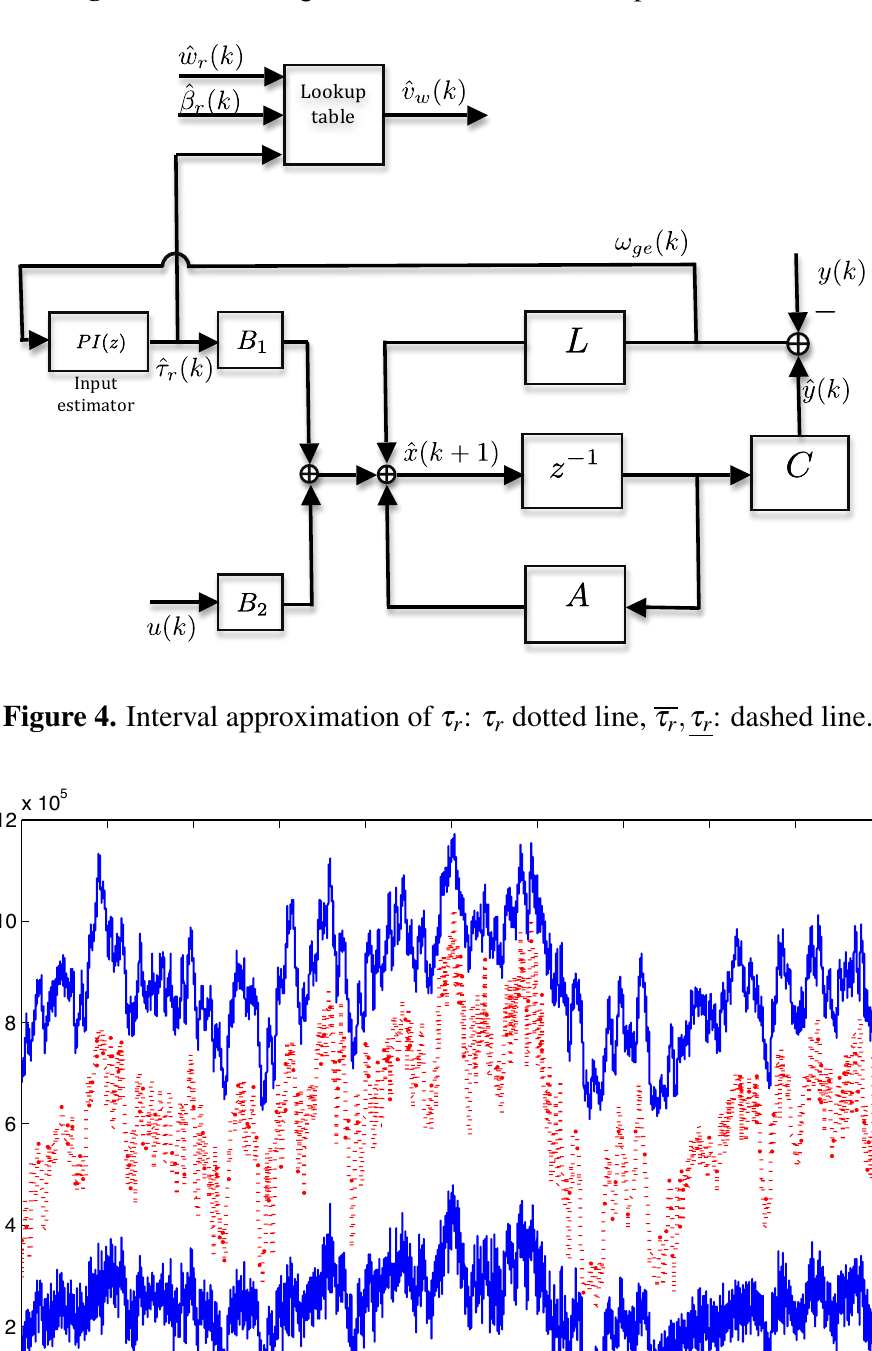
Figure 3. Block diagram of the effective wind speed estimator.